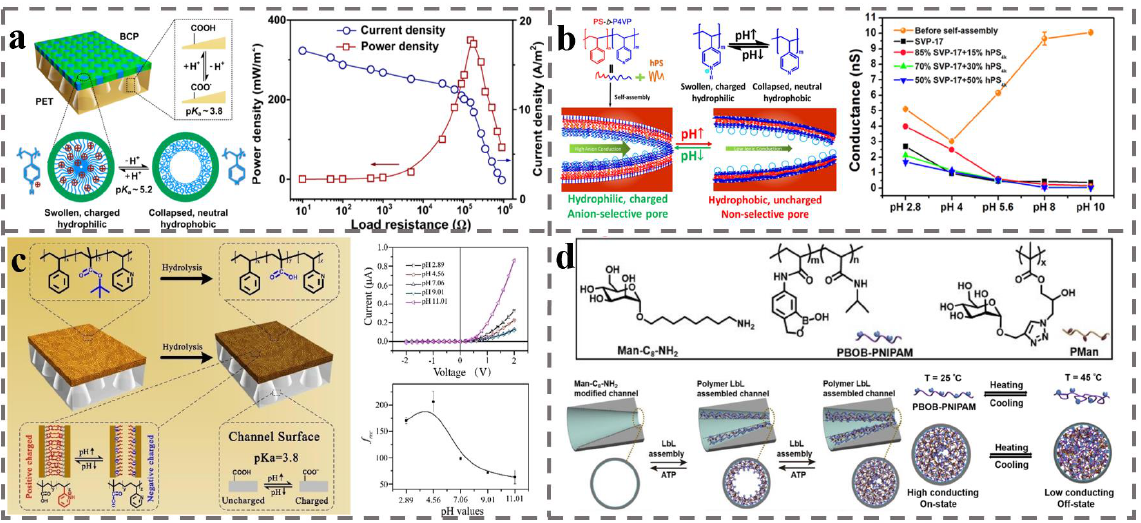
Figure 7. ( a ) Schematic diagram of a hybrid membrane consisting of a pH-responsive BCP membrane and a PET membrane with tapered pores obtained by ion-path etching and its permeation energy conversion efficiency [159]. ( b ) The pH-sensitive ionic conductivity of PS-b-P4VP with h-PS formed by self-assembly of molecular chain morphology with h-PS within bullet-shaped PET nanopores [160]. ( c ) The pH-responsive carboxyl groups, pyridine groups on BCP, and carboxyl groups in the PET pores enable pH-responsive, unidirectional rectification of ions in BCP-PET-laminated membrane [161]. ( d ) Molecular structures of feedstock polymers and synthetic routes to temperature-sensitive hybrid films [162].